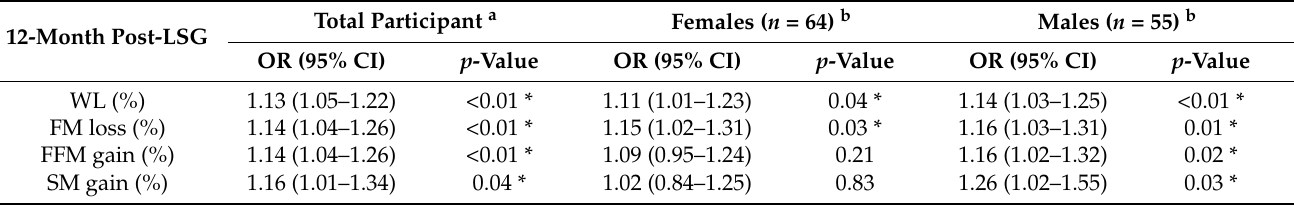
Table 3. Association between body composition changes and type 2 diabetes remission at 12 months